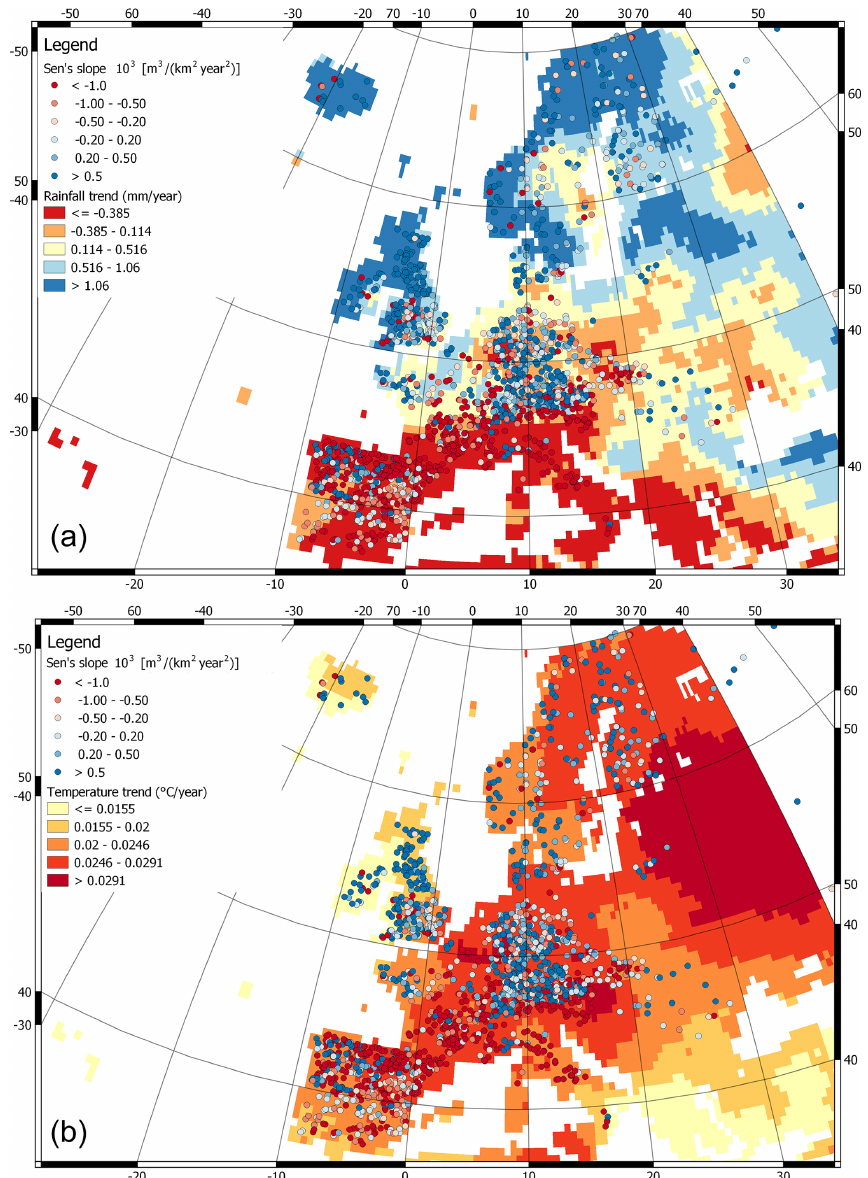
Figure 6. Comparison between the annual streamflow volume trends and daily precipitation (including the snow-to-liquid equivalent) (a) and mean temperature (b) trends over the European continent. Only significant trends are